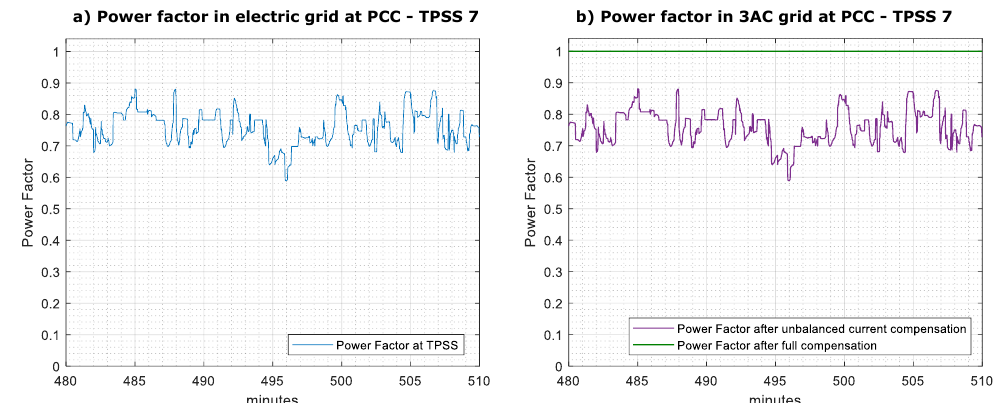
Figure 10. Power factor at substation #7: ( a ) single-phase; ( b ) three-phase, in the three-phase grid side, with different types of compensation.